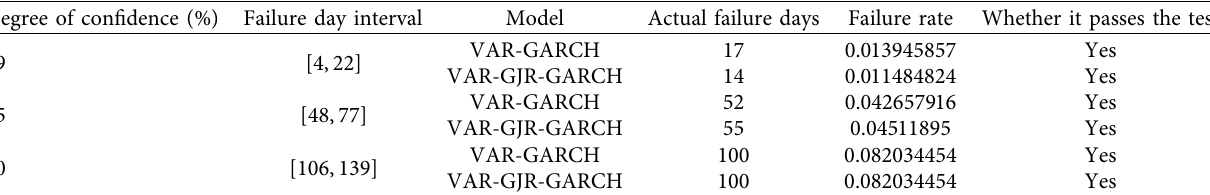
Figure 7: Interval chart of risk days at 90% confidence Table 10: Failure rate test of the two models at different confidence levels.